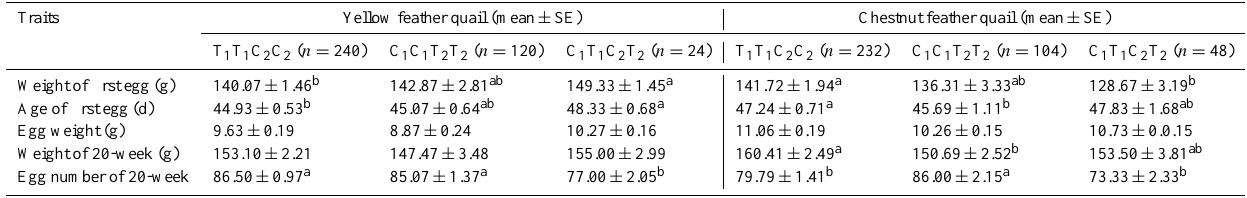
Table 3. Least-squares means and standard errors of the laying traits in two quail populations. Traits